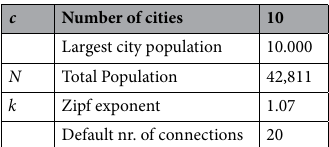
Table 2. Parameters for the simulations.